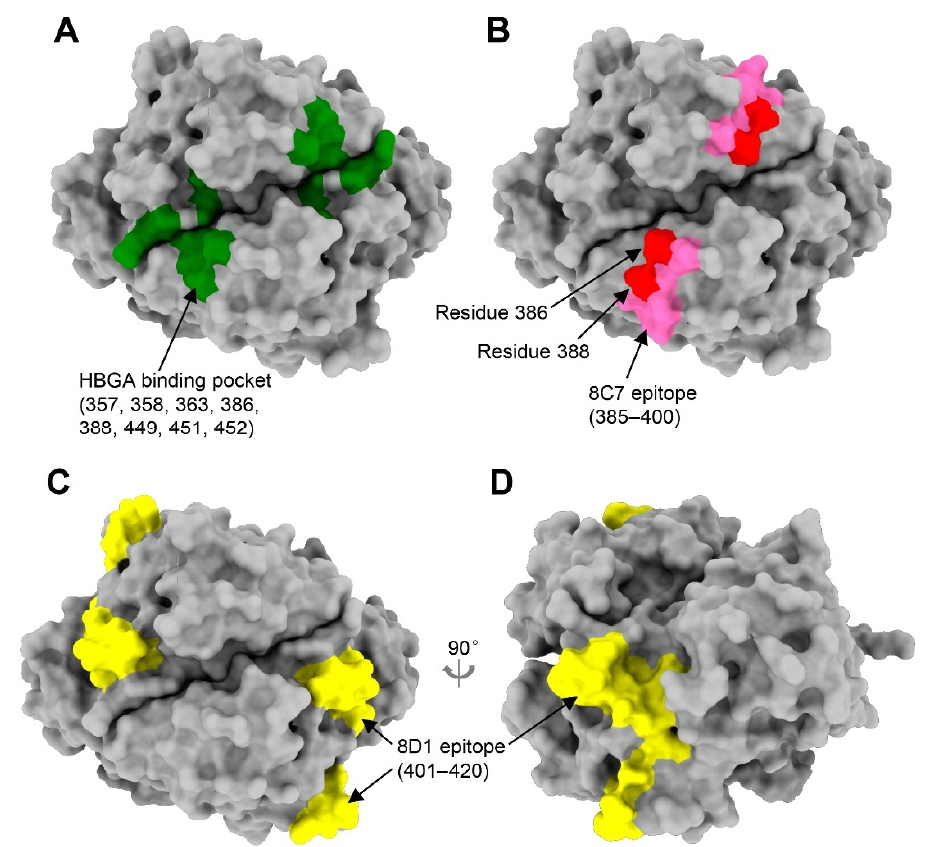
Figure 6. The 8C7 and 8D1 epitopes were mapped onto the surface of the GII.3 P domain dimer (strain TV-24; PDB: 6IR5). ( A ) Model of GII.3 P domain showing the HBGA binding site (green). ( B ) Location of 8C7 epitope (hot pink) on GII.3 P domain surface. Residues 386 and 388 are shown in red. ( C , D ) Location of 8D1 epitope (yellow) on GII.3 P domain surface. Panel ( A – C ), top view; panel ( D ), side view. The corresponding residues in the HBGA binding site or the mAb epitopes are included in the parentheses.